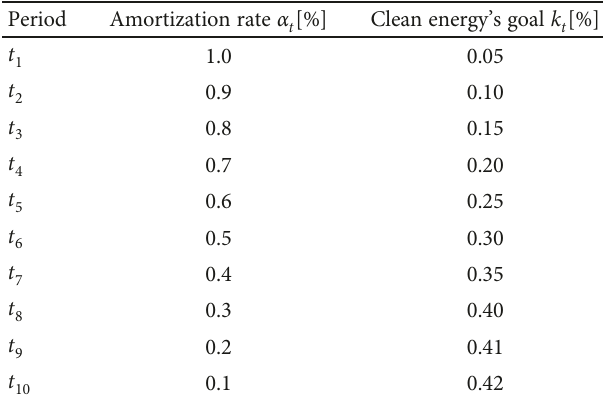
Table 19: Amortization rate per period and clean energy ’ s goal per period.